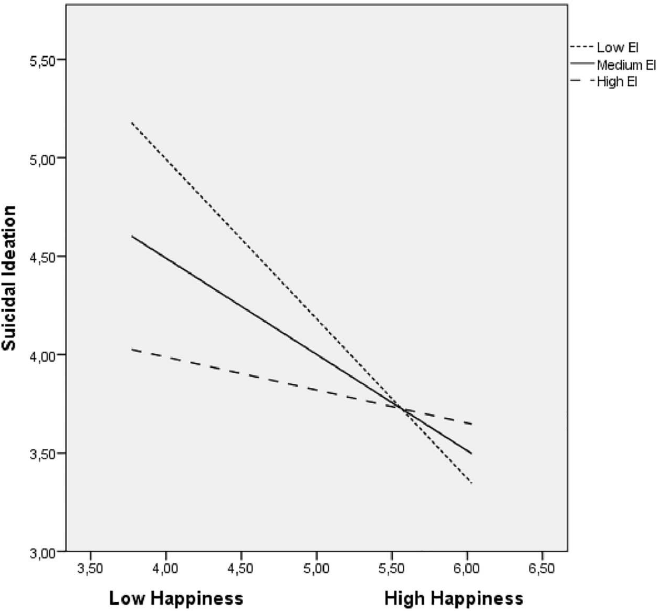
Fig 2. Relationship of happiness and perceived EI for predicting suicidal